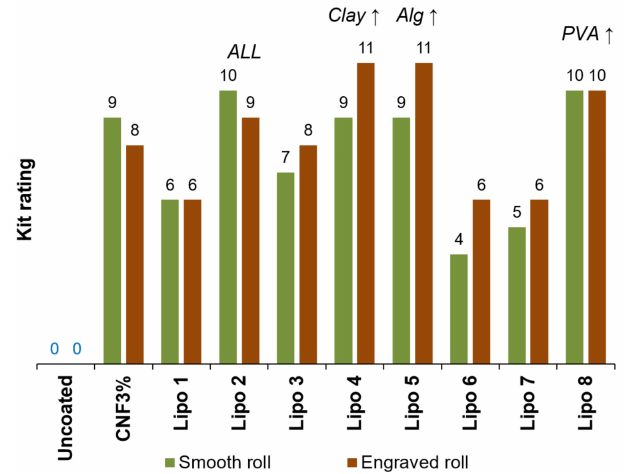
Figure 4. Results of the Kit test (anti-wicking of oil) for uncoated paper and paper that was coated with formulations Lipo 1–8